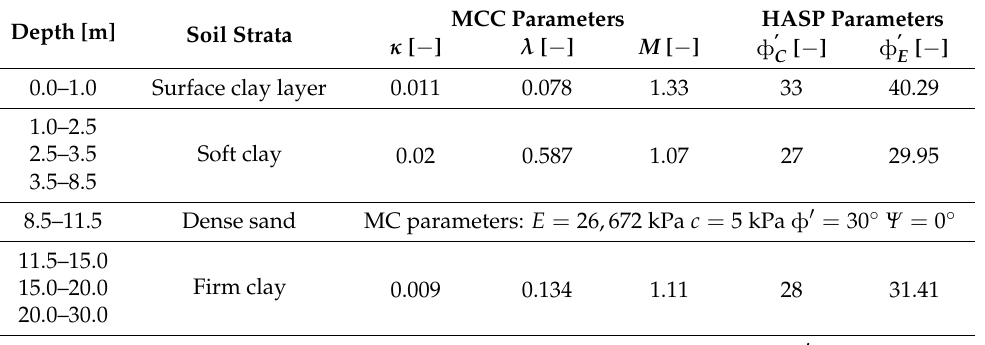
Table 4. Soil model parameters for Embankment B.